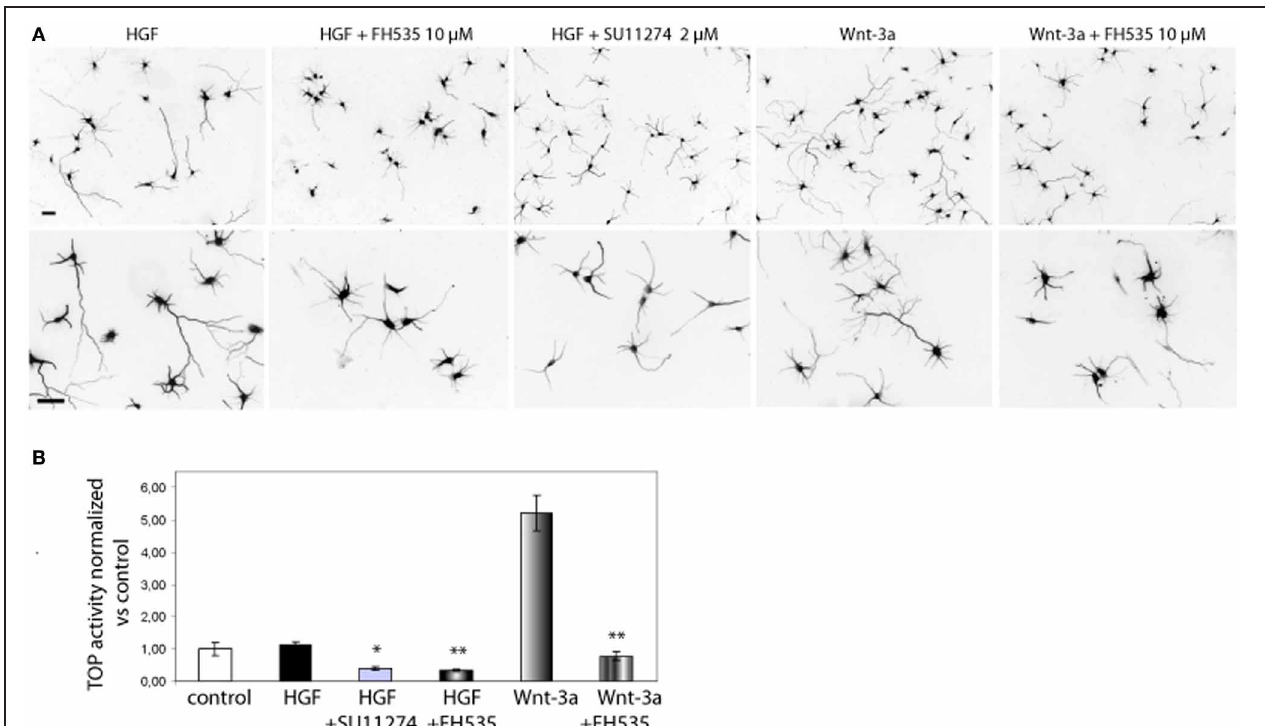
Bars = 30 μ m. (B) β -catenin transcriptional activity determined using the TOP reported plasmid in transfected Hek293 cells. Relative luciferase activity was determined at 48h after transfection. Treatments were applied for the last 24h (see Materials and Methods for details). ∗ p ≤ 0 . 05, ∗∗ p ≤ 0 .